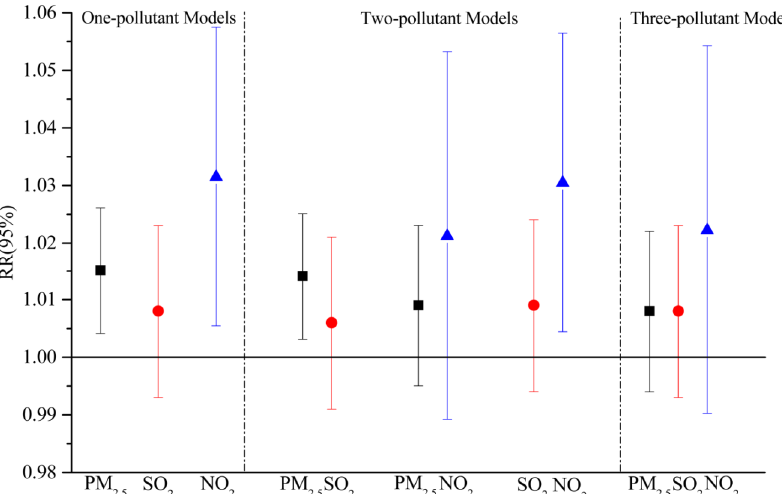
Figure 5. Adjusted estimated relative risk (RRs with 95% CI) of emergency room visits due to respiratory complaints with per 10 µ g/m 3 increase in PM 2.5 , SO 2 and NO 2 in muti-pollutant models for the suburban population in Jinan.